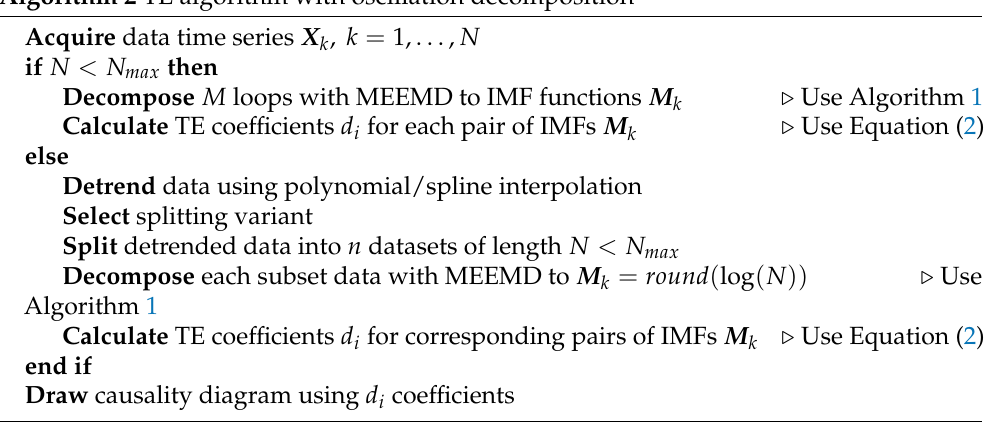
Algorithm 2 TE algorithm with oscillation decomposition